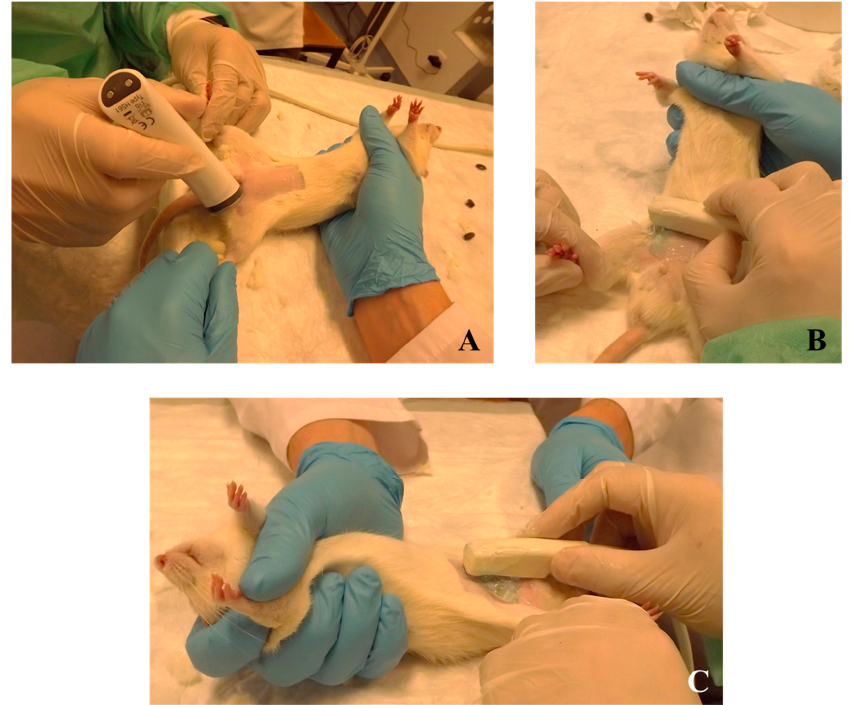
Figure 3. Preparation of a rat for a ultrasonographic exam. The animals should be restrained by a researcher and placed in supine position. The skin of the caudal aspect of the abdomen and the inguinal region should be shaved ( A ). Transverse ( B ) and longitudinal ( C ) scans of the prostate may be performed using B mode. Transverse scan: In the transverse scan, the urinary bladder presents as a round to oval shape filled with urine (anechoic structure) and the prostate lobes are visible around the urinary bladder. The ventral prostate lobes appear as hypoechoic elongated structures (one right and one left) with a hyperechoic capsule, placed ventrally to the urinary bladder (Figure 4A, B). In this scan, the dorsal prostate is only observed close to the urinary bladder neck (urinary bladder with low diameter, almost disappearing from the screen) (Figure 4B). The dorsal prostate appears as a round hypoechoic structure with a hyperechoic capsule, placed dorsally to the urinary bladder. The seminal vesicles (accessory glands of the male genital tract) are also observed in this transverse scan. They are seen as the hypoechoic elongated structures (less hypoechoic when compared with prostate gland lobes), placed dorsally to the urinary bladder, in the transition area between the cranial abdomen and urinary bladder neck (Figure 4A).